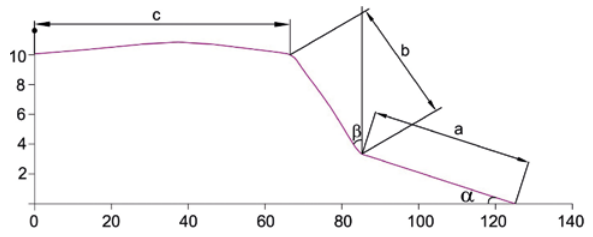
Note : Distances: a – beach width; b – width of the western slope of the protective beach dune ridge; c – width of the top of the protective beach dune ridge. Distances are measured using a ca- librated roulette and expressed in meters. Inclines measured in degrees: α – beach incline, β – incline of the western slope of the protective beach dune